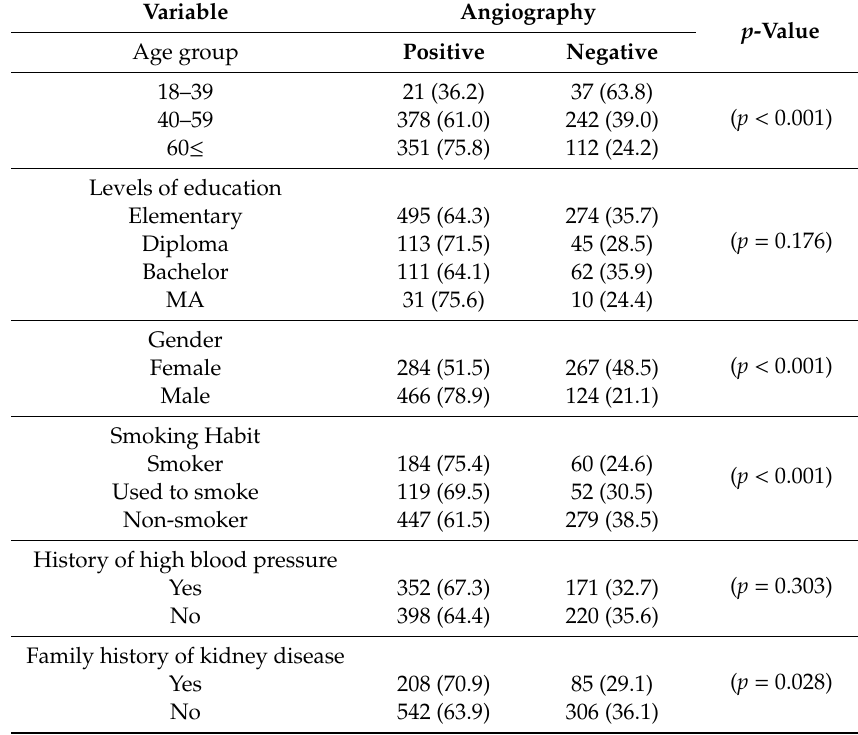
Table 1. Comparison of frequency of subjects’ demographics and risk factors based on the result of